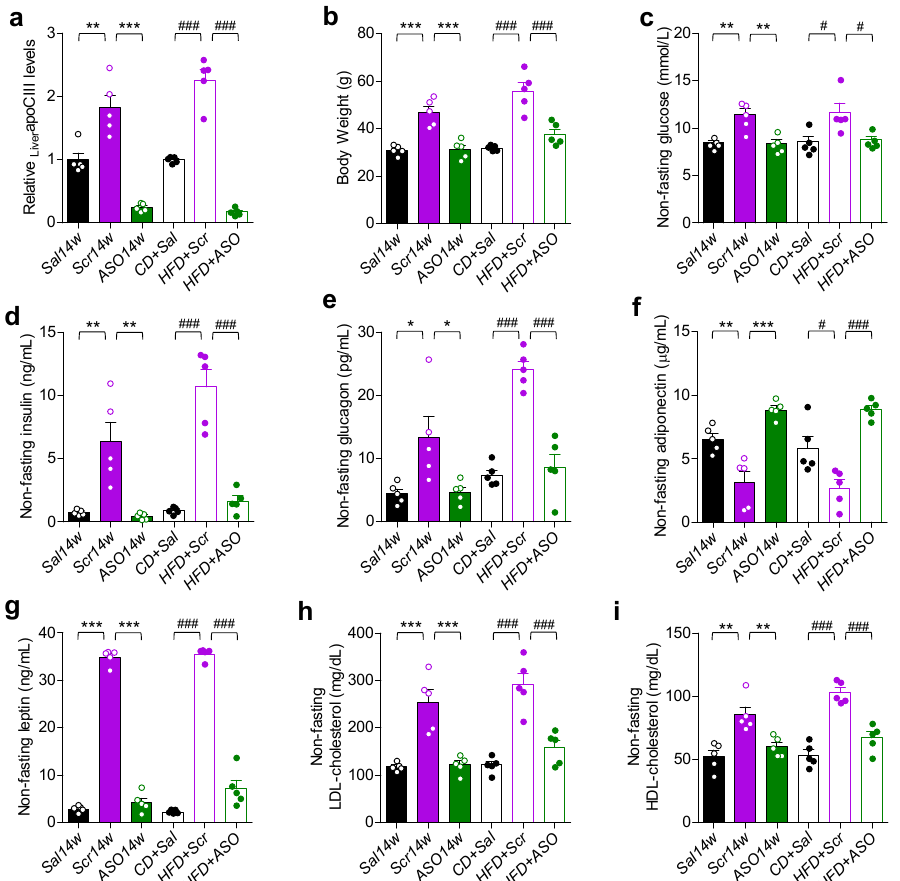
Figure 1. Reducing apoCIII improves metabolic status. ( a ) Liver apoCIII mRNA levels analyzed by qRT-PCR at the end of the prevention (filled bars) and reversibility (empty bars) studies. ( b ) Body weight. ( c – i ) Non-fasting ( c ) glucose, ( d ) insulin, ( e ) glucagon, ( f ) leptin, ( g ) adiponectin, ( h ) LDL- cholesterol and ( i ) HDL-cholesterol measured at the end of the prevention (filled bars) and reversibility (empty bars) studies. Data are expressed as mean ± SEM of n = 5 individual mice per experimental group and controls. * p < 0.05; ** p < 0.01; *** p < 0.001 for differences in the prevention study. # p < 0.05; ### p < 0.001 for differences in the reversibility study.